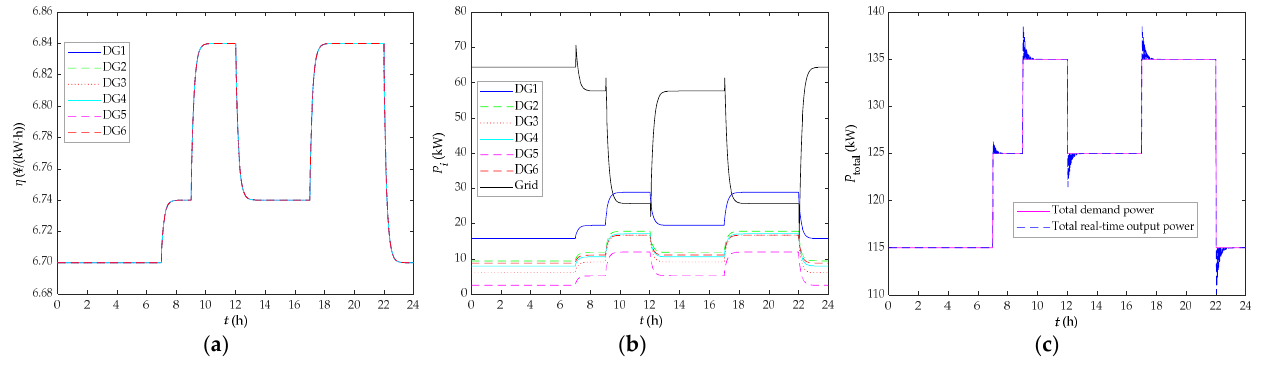
Figure 12. The change curves of variables of the system under TOUP of the whole day and variable load condition: ( a ) change curves of each DG’s ICR; ( b ) change curves of each DG’s active output and grid output power; ( c ) change curves of the cumulative sum of each DG’s active output and grid output power as well as total demand power.